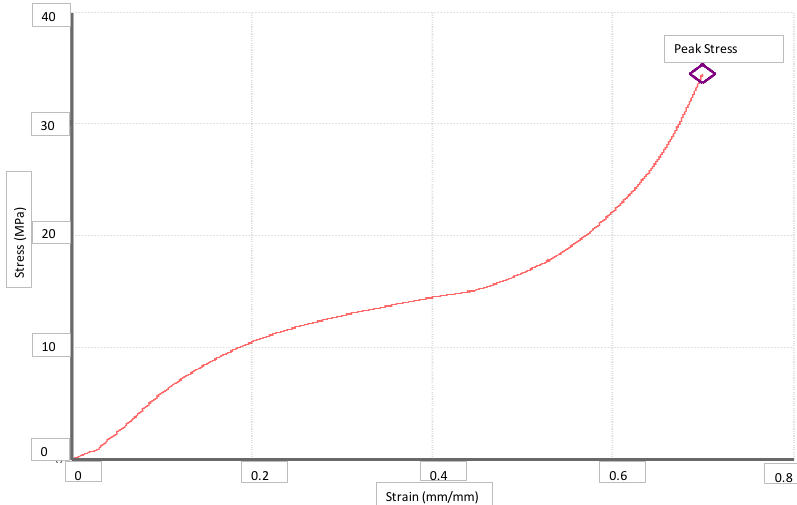
Figure 9. Stress-strain curve of the scaffolds from run 5.